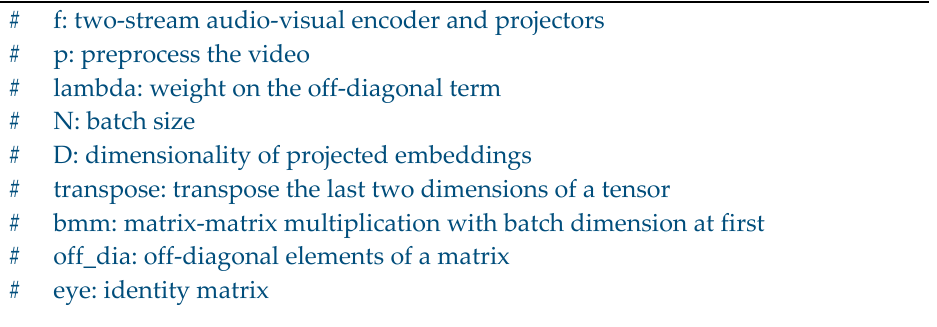
Algorithm 1 PyTorch ‐ style pseudocode for Audio ‐ Visual Barlow